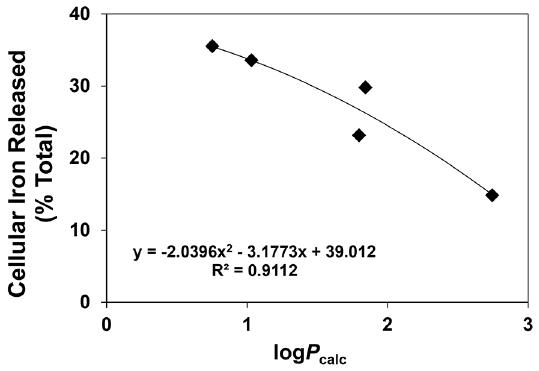
Figure 7. Relationship between the cellular iron released (% total) and lipophilicity (log P calc ) of series 1 chelators using SK- N-MC neuroepithelioma cells. Lines were fitted in using Microsoft Excel 2010 (Microsoft, Redmond, WA).